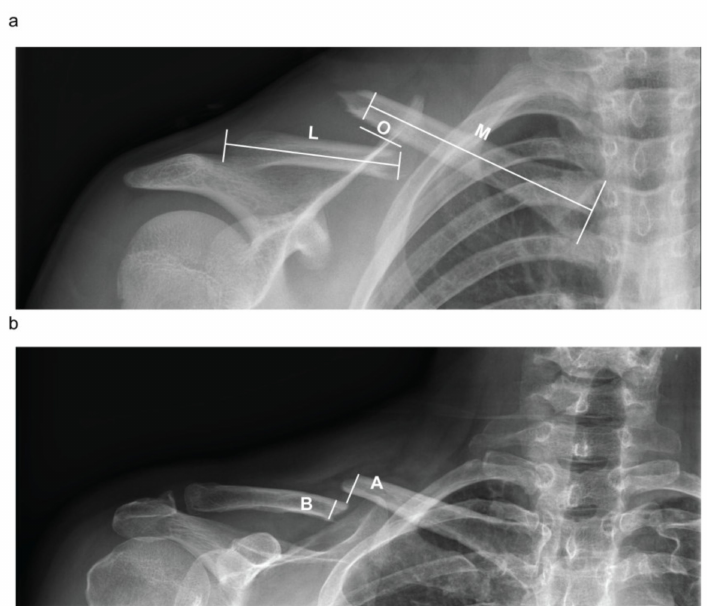
Figure 1. Clavicle shortening and displacement evaluation. ( a ) Clavicular shortening, defined as the overlap of proximal and distal fragments, was assessed as a percentage of the ipsilateral clavicular length on a standard antero-posterior view = O %. ( b ) The amount of fragment displacement, M + L defined as the amount of vertical translation, was assessed as a percentage of the clavicle shaft width at the fracture site on a 20 ◦ cephalic tilt view of the clavicle. D = A % O = overlapping; M = medial B clavicle fragment length; L = lateral clavicle fragment length; A = cortex-to-cortex distance; B = clavicle width; S = shortening; D =